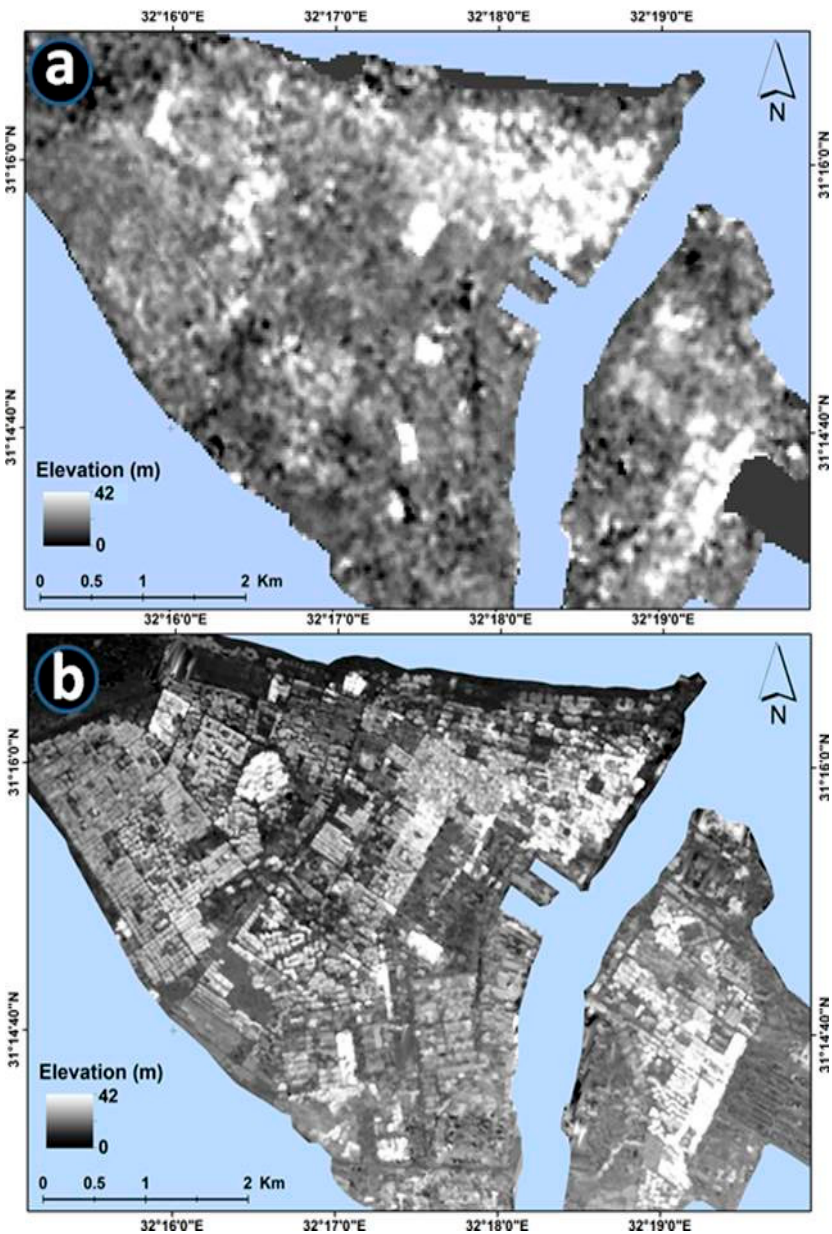
Figure 13. Comparison of: ( a ) the SRTM derived DEM; and ( b ) the newly generated DEM from ALOS/PRISM of Port-Said